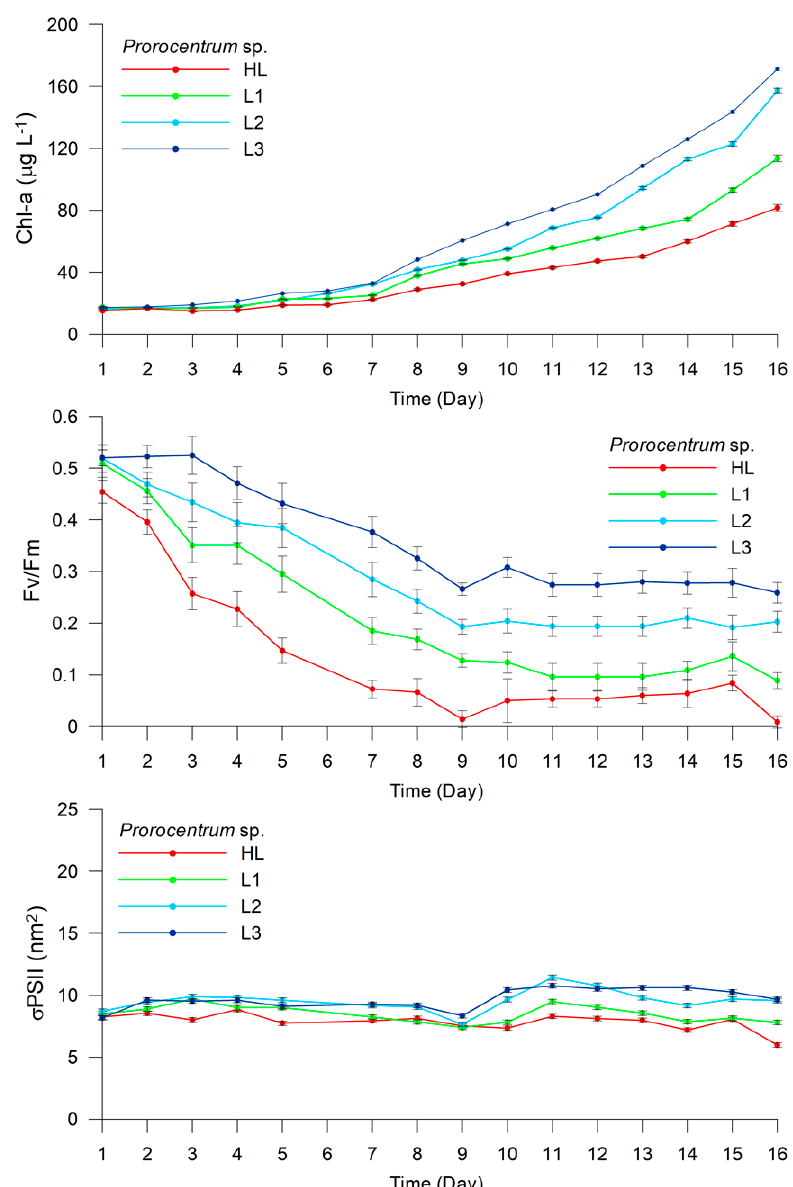
Figure 6. Experiment 2. Changes in Chl-a concentration ( µ g L − 1 ), Fv / Fm, and σ PSII (nm 2 ) in Prorocentrum sp. under different light intensities (high light (HL), low light 1 (L1), low light 2 (L2), and low light 3 (L3)).